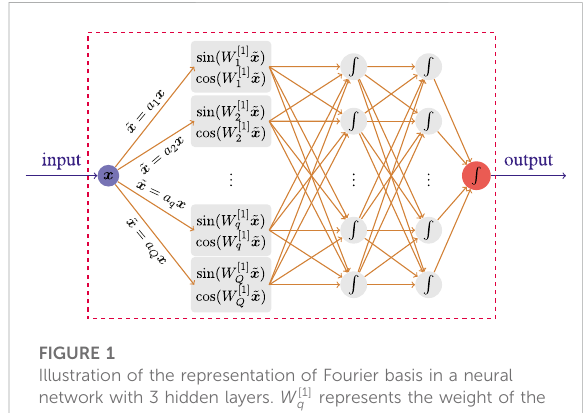
FIGURE 1 Illustration of the representation of Fourier basis in a neural network with 3 hidden layers. W [ 1 ] q represents the weight of the q − th hidden units in the fi rst hidden